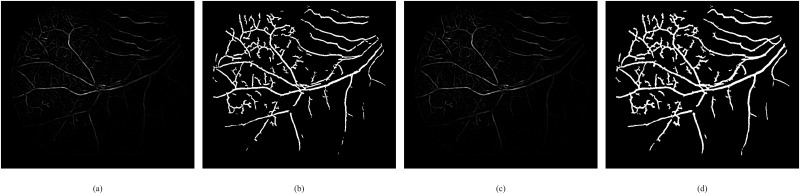
Analysis of Frangi filtering enhancement using STARE dataset.A (a) Thin vessel enhanced image (b) Thin binary image (c) Thick vessel enhanced image (d) Thick binary image.